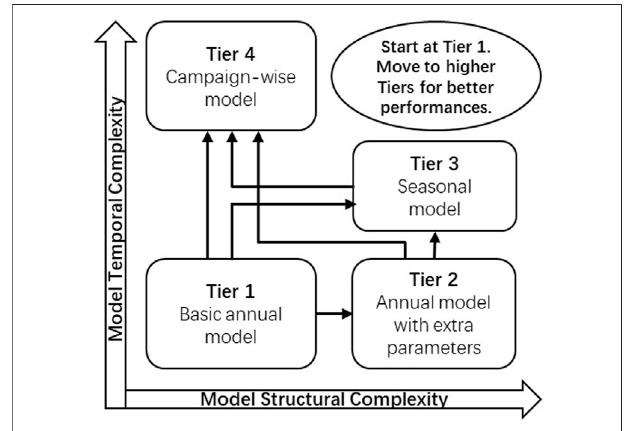
FIGURE 1 | Methodological framework guiding the selection of gap- fi lling